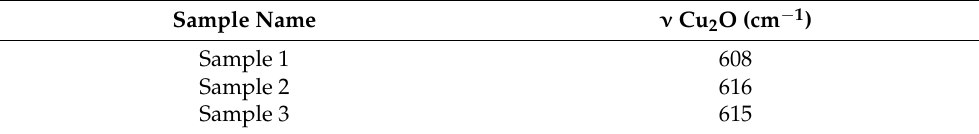
Table 4. Transmission peaks for Cu 2 O: N thin films [42].